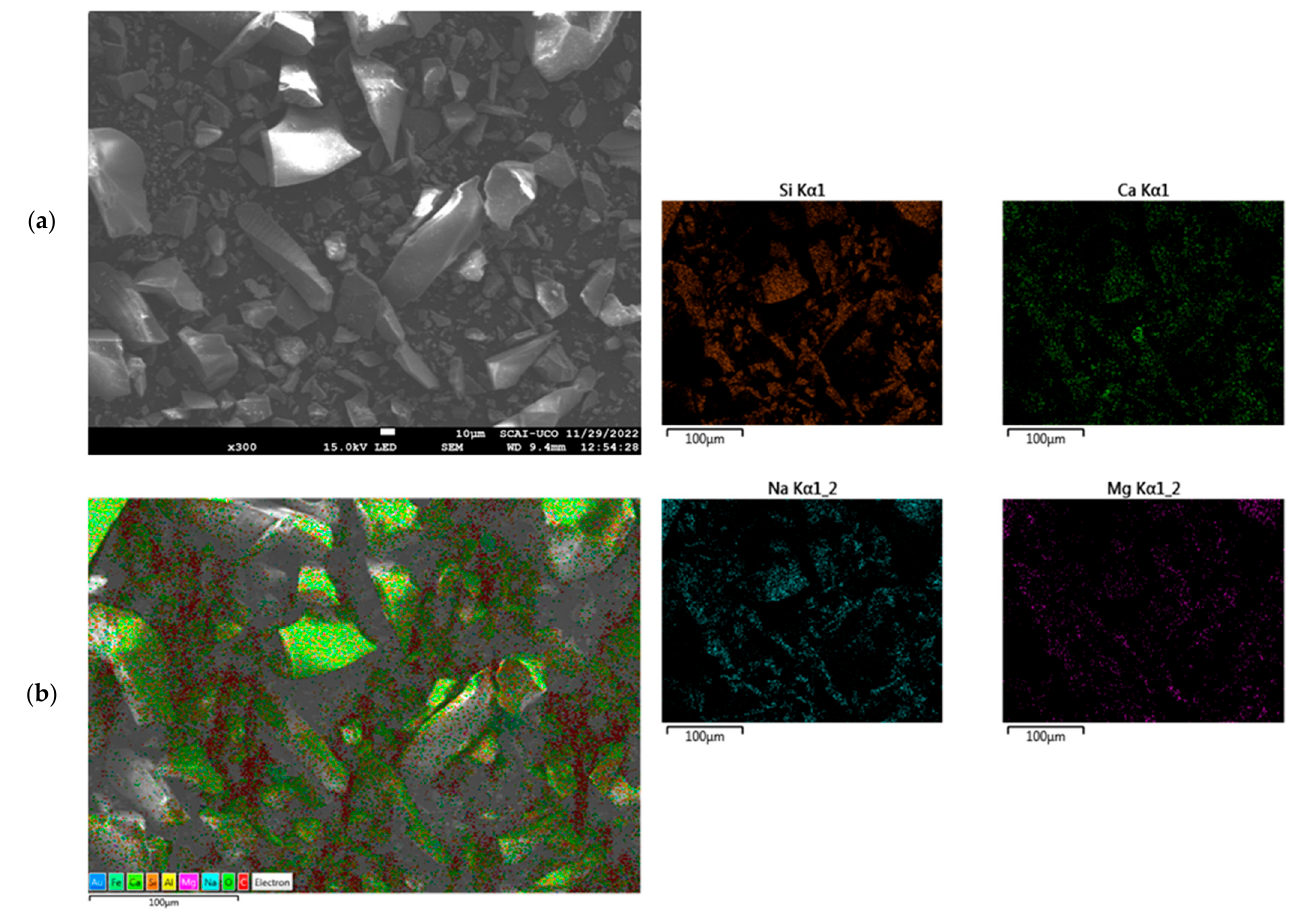
Figure 4. SEM images ( a ) and mapping ( b ) for WGR.